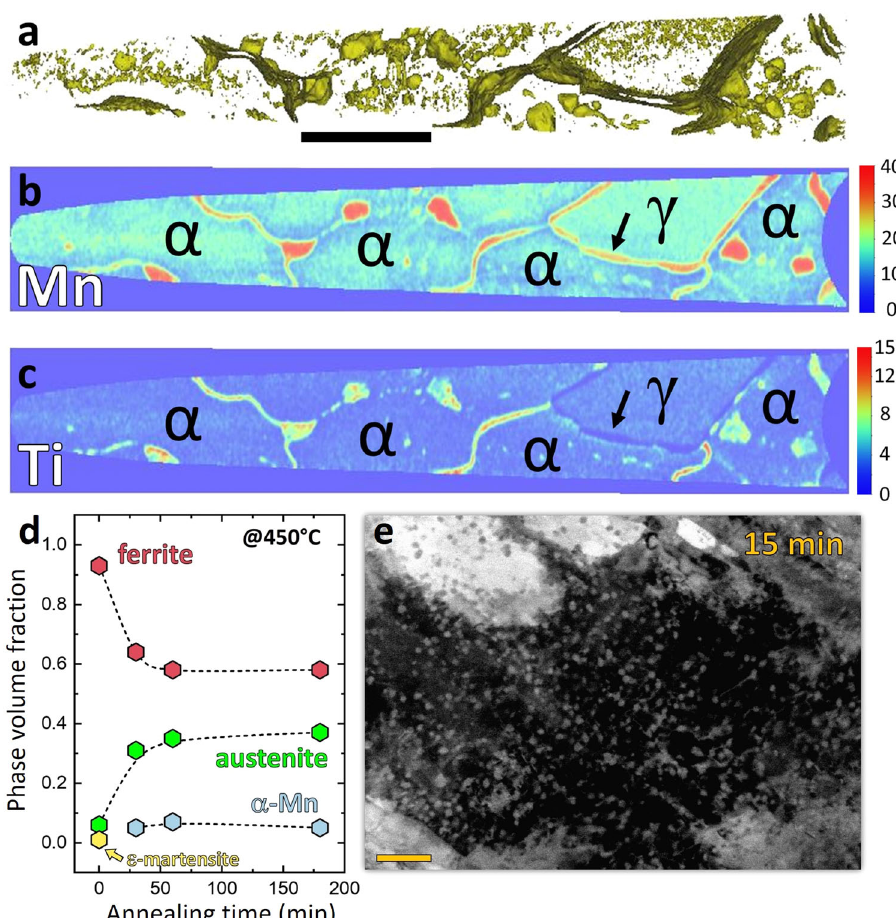
Fig. 2 Microstructural analysis. a APT reconstruction showing a 20at% Mn iso-surface. b 2D map of the Mn composition (in at.%). c 2D map of the Ti composition (in at.%). Scale bar, 100 nm. d Evolution of the fraction of the different phases after a given annealing time at 450 °C. e Microstructure after 15 min of aging at 450 °C. Scale bar, 200